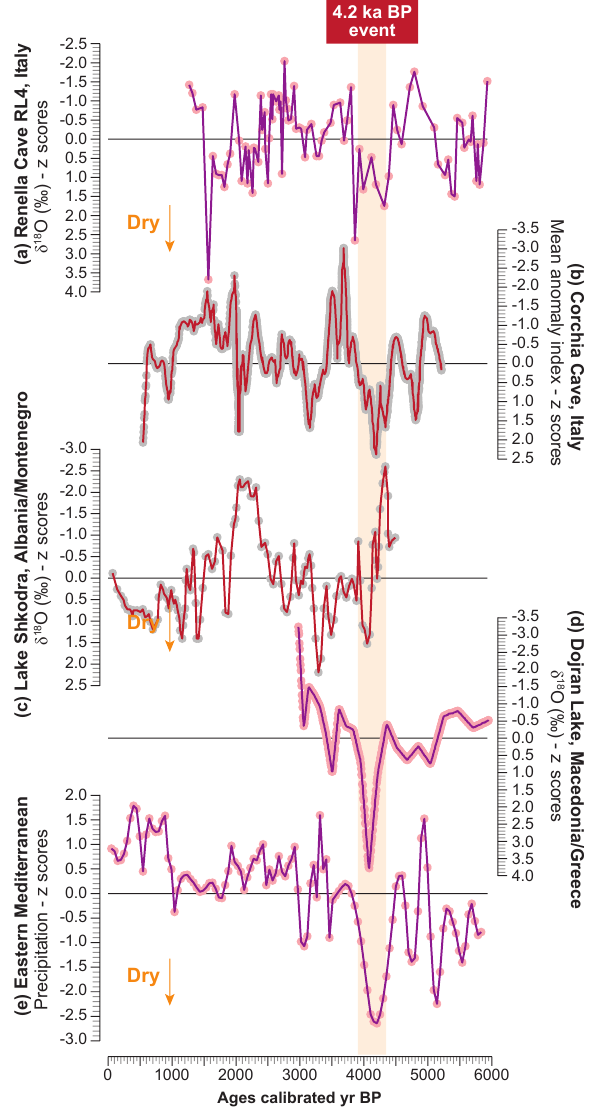
Figure 2. Paleoclimate series ( z score transformed), with the type of climate proxy noted. The orange vertical band represents the 4.2kaBP event. From top to bottom: Renella Cave (Italy; Drysdale et al., 2006; Zanchetta et al., 2016), Corchia Cave (Italy; Regattieri et al., 2014), Lake Shkodra (Albania and Montenegro; Zanchetta et al., 2012), Lake Dojran (Macedonia and Greece; Francke et al., 2013; Thienemann et al., 2017), and the eastern Mediterranean (Kaniewski et al.,